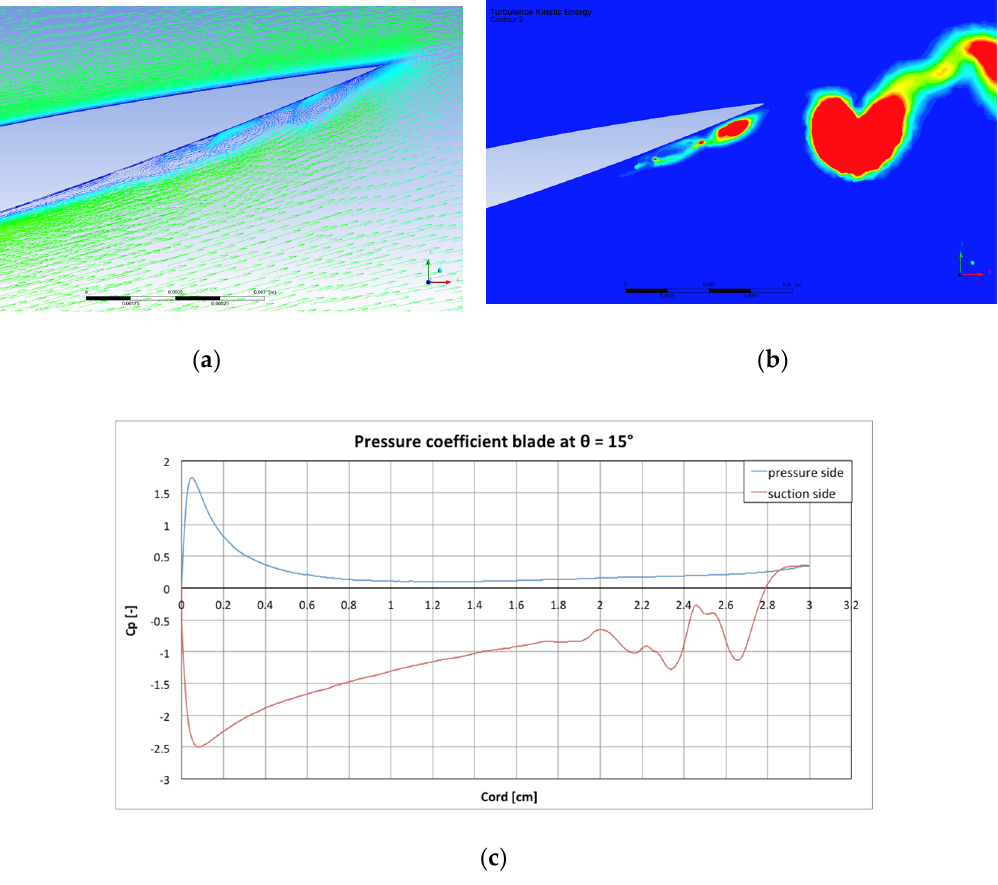
Figure 16. Velocity vectors ( a ), contours of turbulence kinetic energy ( b ) and pressure coefficient ( c ) for a blade at azimuthal position θ = 15° and λ max = 0.29.